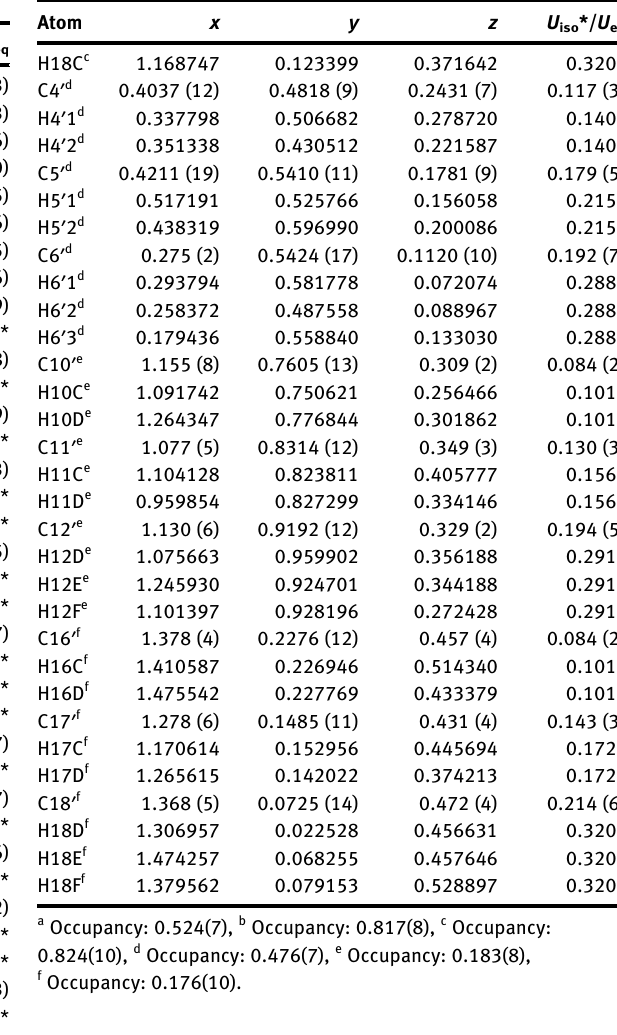
Table  : Fractional atomic coordinates and isotropic or equivalent isotropic displacement parameters (Å 